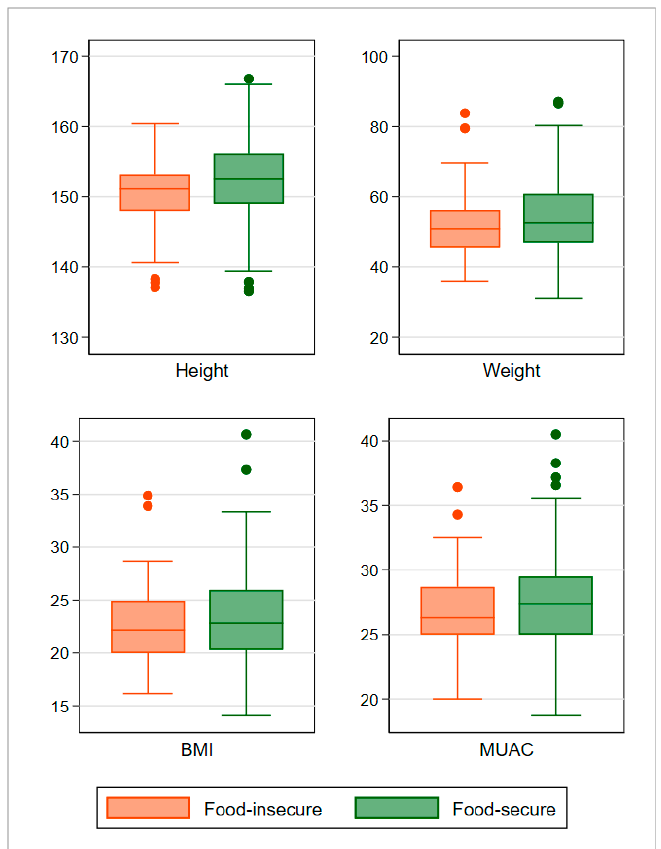
Figure 1. Height (cm), weight (kg), BMI (kg/m 2 ), and MUAC (cm) among early-gestation pregnant women in Matlab, after matching (weighted), by household food security status.